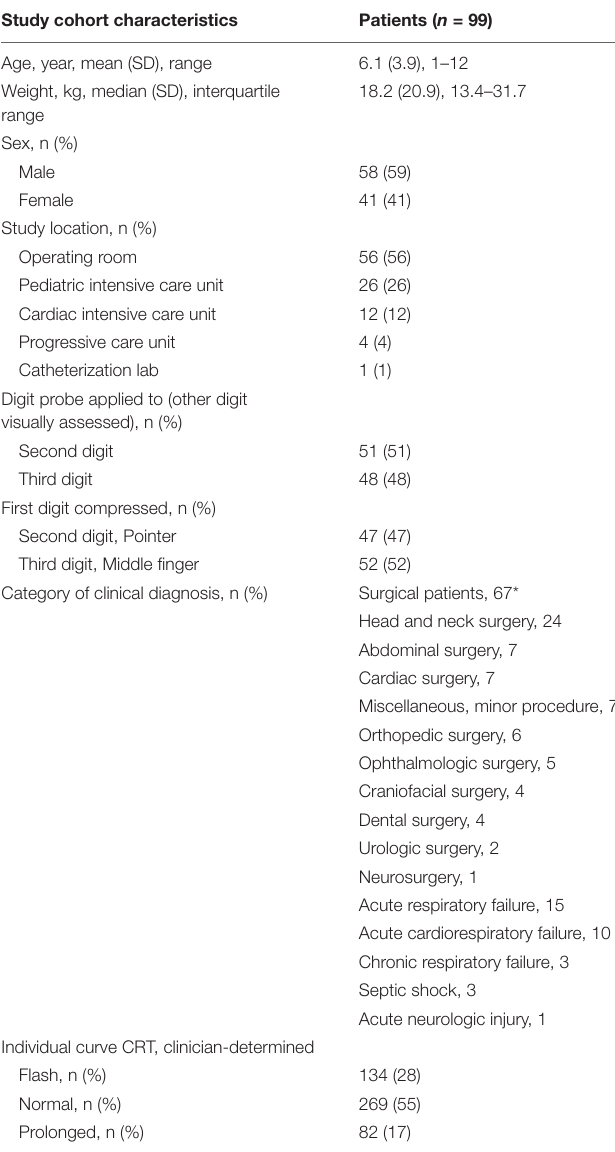
TABLE 1 | Demographic and clinical characteristics of study and validation cohort. Study cohort characteristics Patients ( n =